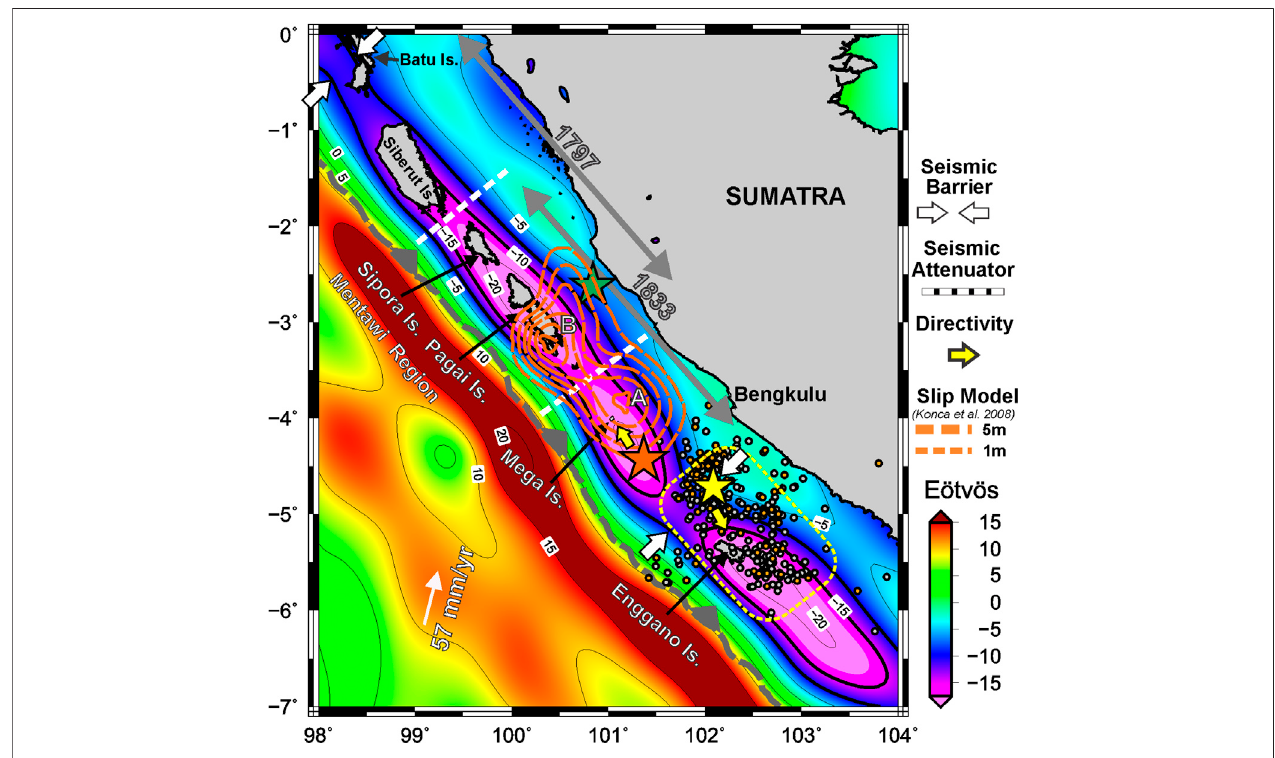
FIGURE 8 | Cumulative slip model (dashed orange contours) for the September 2007 sequence (Konca et al., 2008) superimposed to the topography corrected vertical gravity gradient (Tzz) obtained from GOCE model GO_CONS_GCF_2_DIR_R6 up to N = 200 (Bruinsma et al., 2014). Stars indicate epicenter location for each event: Mw = 8.4 (orange), Mw = 7.9 (green). The Enggano 2000 Mw = 7.9 earthquake (yellow star) ruptured to the South as indicated by the aftershock activity (orange circles are from Pan et al. (2001) and gray circles are from USGS database).The dashed yellow rectangle shows the approximate rupture area (Abercrombie et al., 2003). The dashed white line indicates the location of regions that behaved as seismic energy attenuators; white arrows indicate the existence of a seismic barrier that